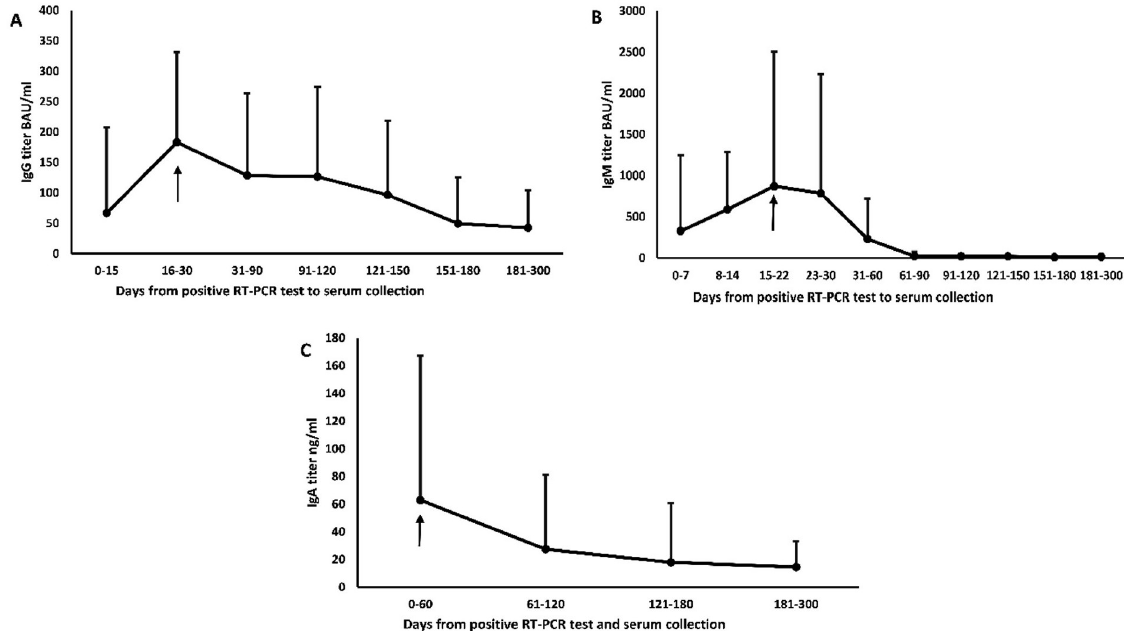
Fig 1. Dynamic of immunoglobulins response for COVID-19 confirmed patients (mean ± SD, n = 233). (A) IgG, (B) IgM, and (C) IgA. The black arrow indicates the peak